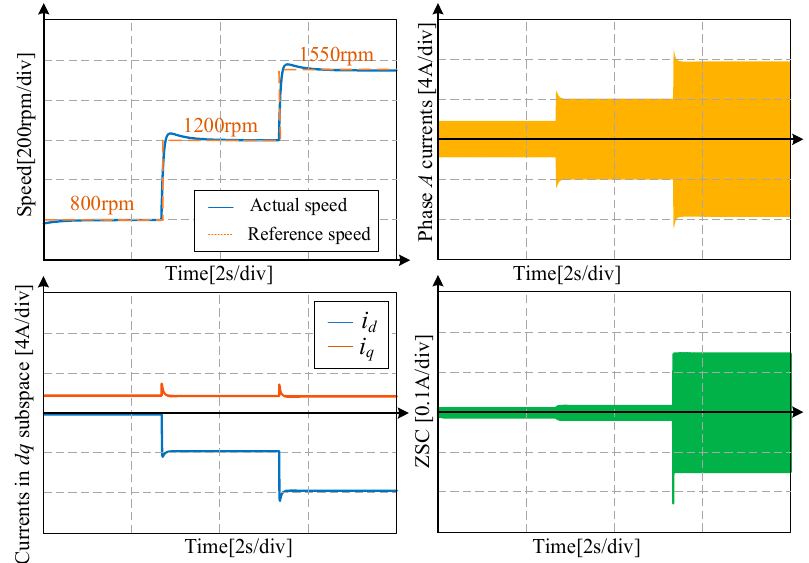
ZSC in exchange for higher bus voltage utilization. Thus, the precise fundamental current generation and larger ZSC are observed.